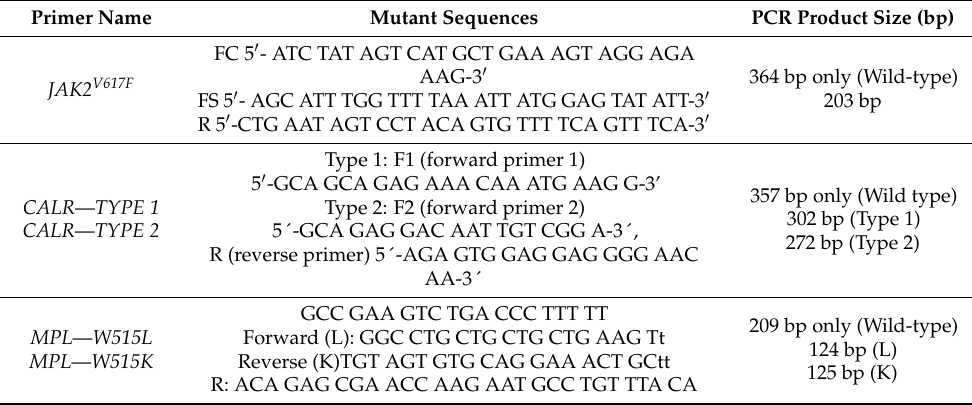
Table A2. Primers for JAK2 V617F, CALR, and MPL mutation